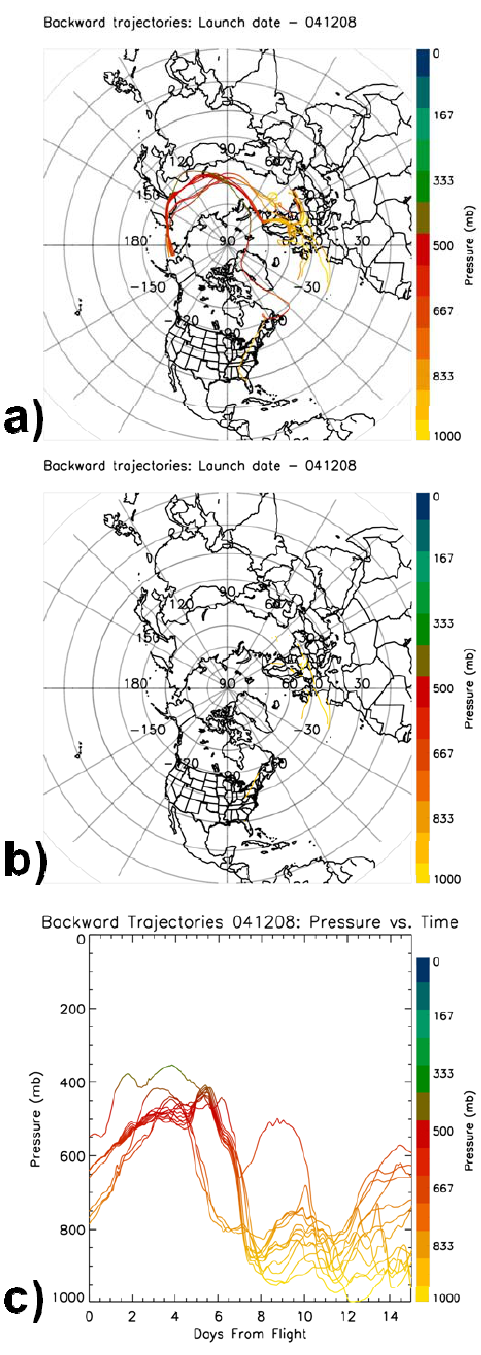
Fig. 15. As in Fig. 6, but for leg 8 on 12 April 2008.